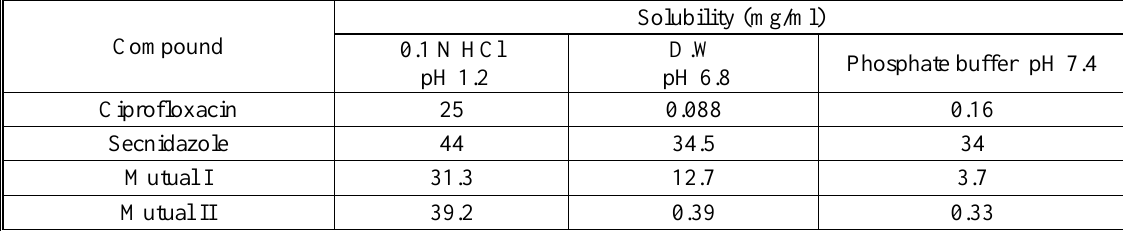
Table 3. The solubility-comparison study